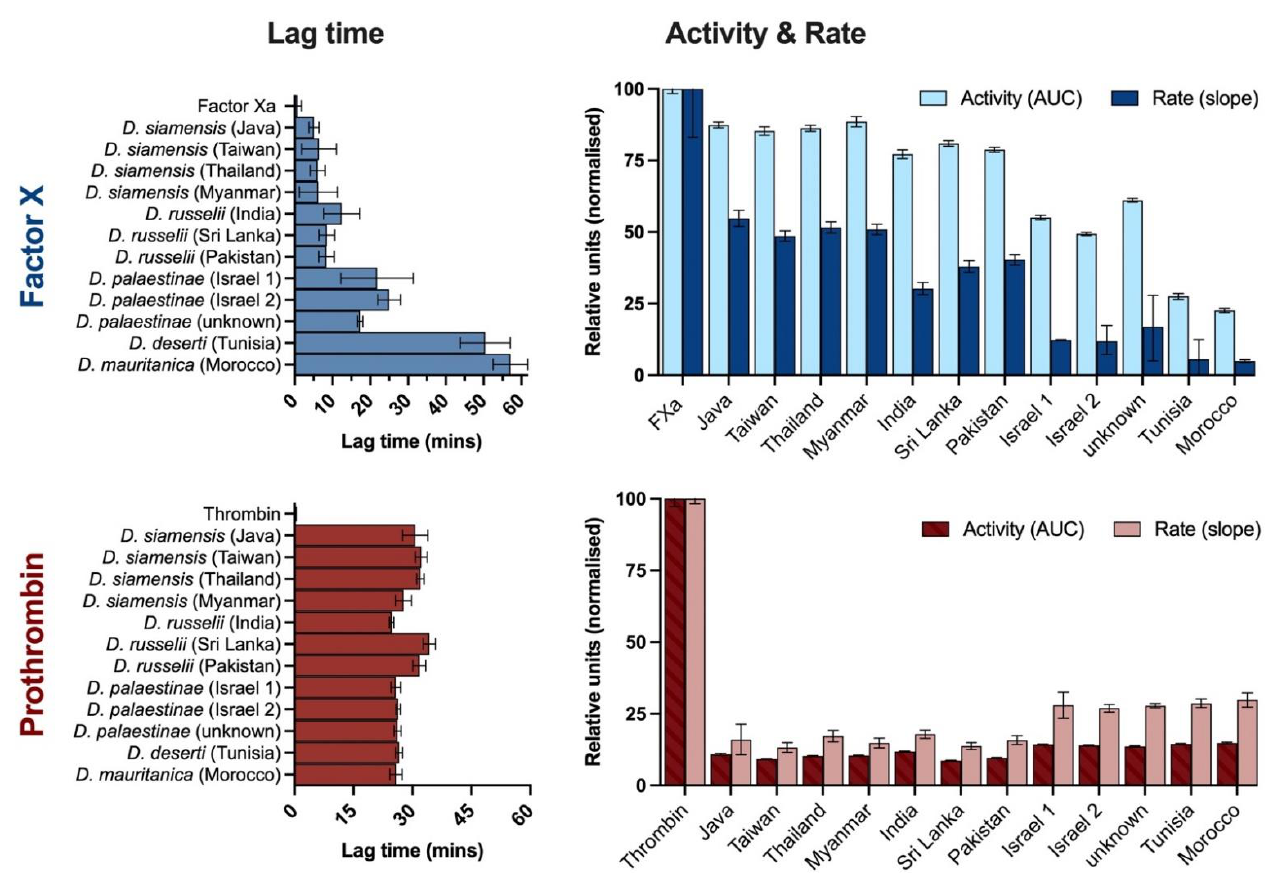
Figure 8. Lag time (minutes until commencement of linear phase; left column ), total activity (area under the curve (AUC) of fluorescence over time; right column) and peak rate (slope at linear phase; right column ) of 100 ng/mL of human factor X ( top row , blue) and prothrombin ( bottom row , red) cleavage by 100 ng/mL Daboia venoms, incubated at 37 ◦ C for 150 min. Activation is calculated as the relative luminescence units (RLU) emitted by wells containing venom + zymogen + substrate after subtraction of venom + substrate control RLU. Data are the mean with 95% confidence intervals of at least three replicates; activity and rate data are normalised to the positive control (100 ng/mL human factor Xa (FXa) or